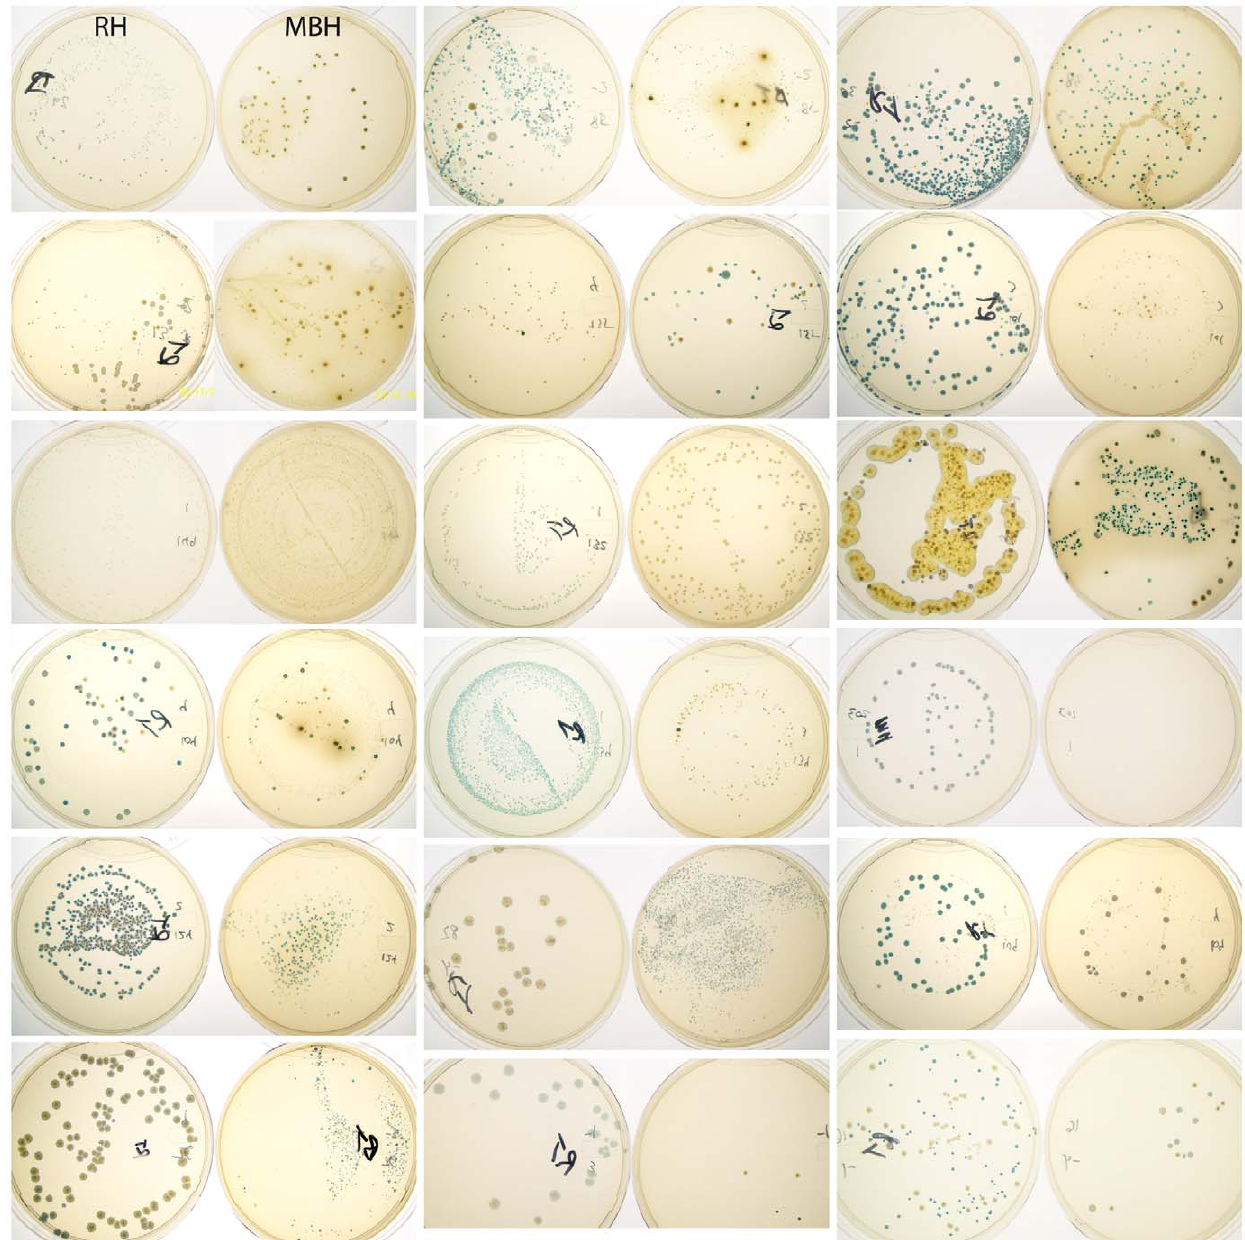
Figure 2. Primary isolation on chromogenic media. Vaginal samples were serially diluted and plated on RH (left) and mBH (right) media containing glucose as carbohydrate source (see Methods). One of four dilutions inoculated for each of 18 selected samples on both media are shown. A single sample did not grow on mBH (fourth sample down on right side). Note dark green and bright yellow colonies, possibly indicating elevated concentrations of H 2 O 2 in the surrounding media.